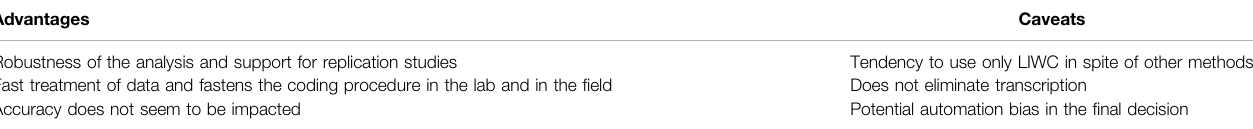
TABLE 2 | Advantages and caveats of computational stylometry in deception